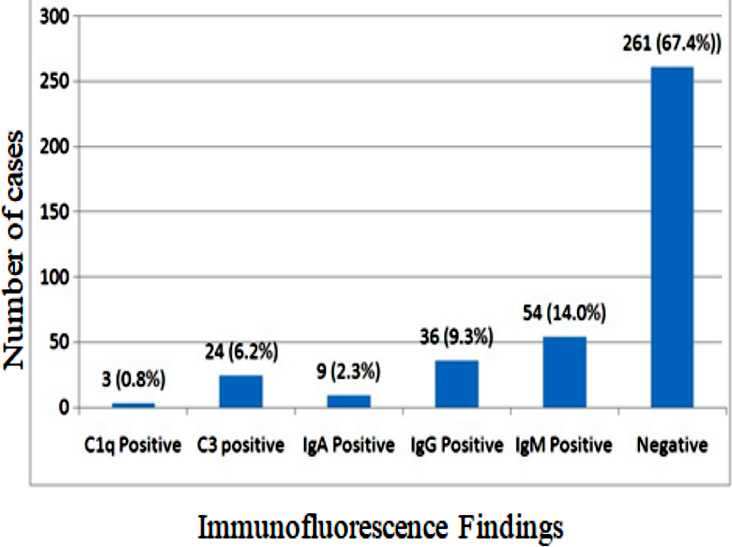
Distribution of GN cases with regards to Immunofluorescence Findings in children undergoing renal biopsies (n=387).